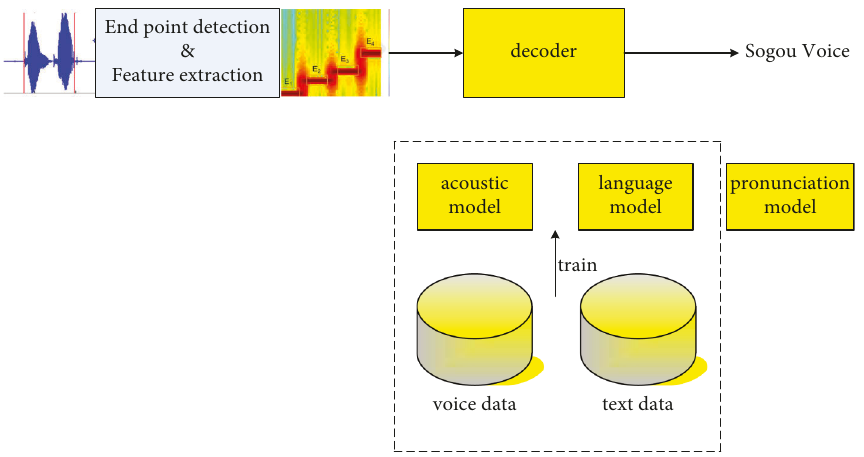
Figure 1: Speech feature extraction.